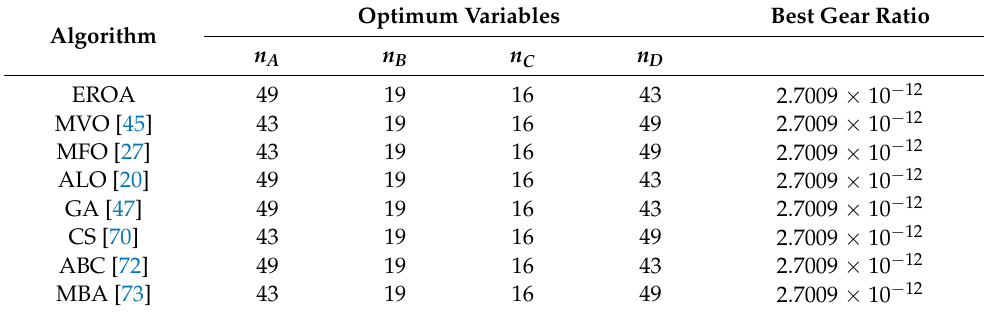
Table 15. Optimization results for the gear train design